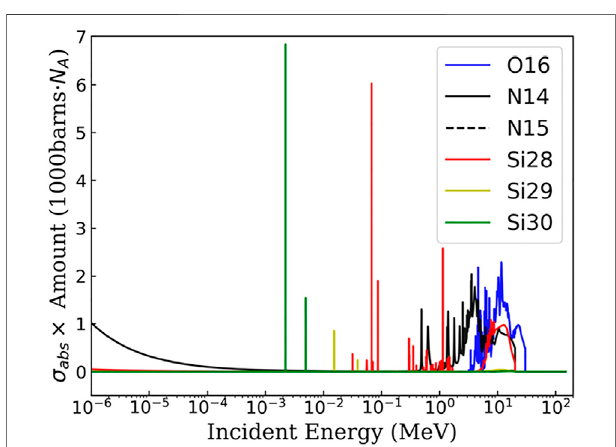
FIGURE6| σ abs × N withthechangeoftheincident energy ofneutronof O16 when UO 2 is implemented in the annular fuel design, that of Si28, Si29, and Si30 when U 3 Si 2 is implemented and that of N14 and N15 when UN is implemented. σ abs is the microscopic neutron absorption cross section and N is the number of nuclides. N A (cid:2) 6 . 02 × 10 23 . The data of cross section refer to